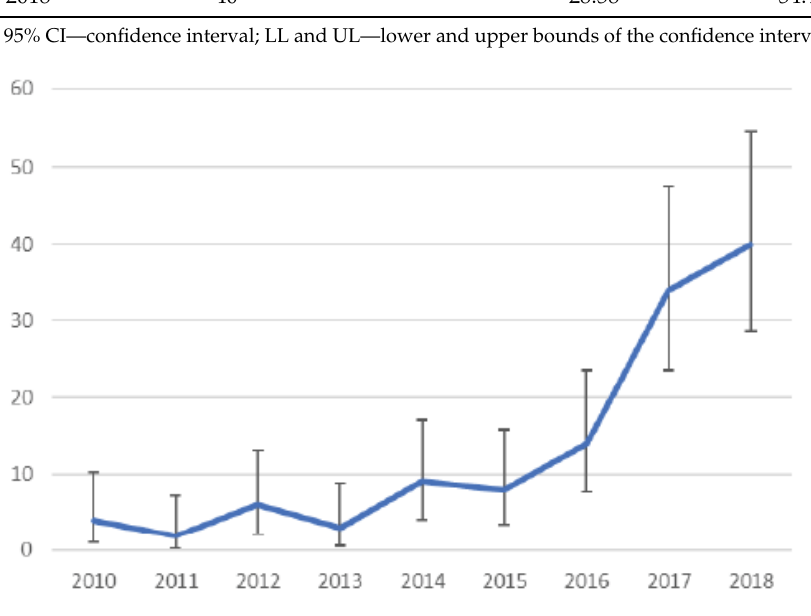
highest number of interventions was in April and the lowest in November. There was a statistically significant difference between the abovementioned months. ( p = 0.027). The frequency of interventions was not significantly different between the other pairs of mont hs. The results are presented in Table 5.